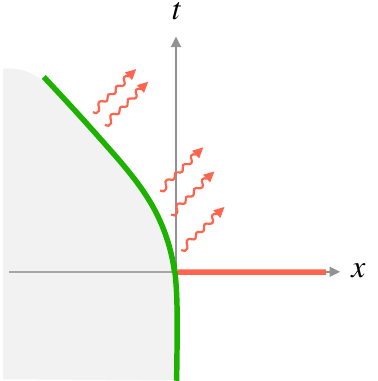
Figure 1 . A moving mirror (green curve), being the boundary of the quantum system (red line) under consideration, accelerates to the left while approaching the null line. This generates radiation in form of right moving quanta (red, wiggly